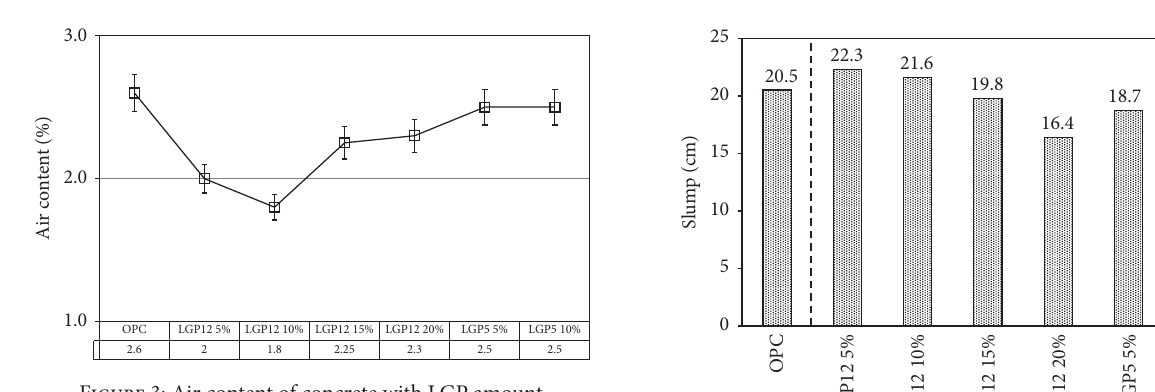
Figure 3: Air content of concrete with LGP amount.